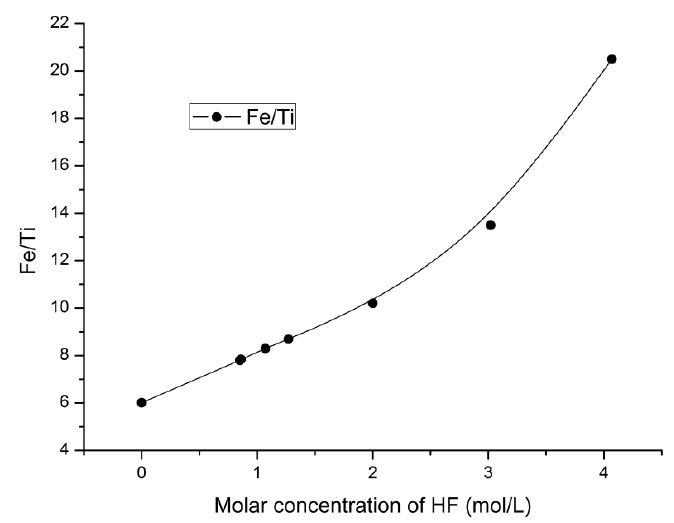
Figure 8. The Fe/Ti ratio in solid samples vs. concentration of ammonium fluoride.